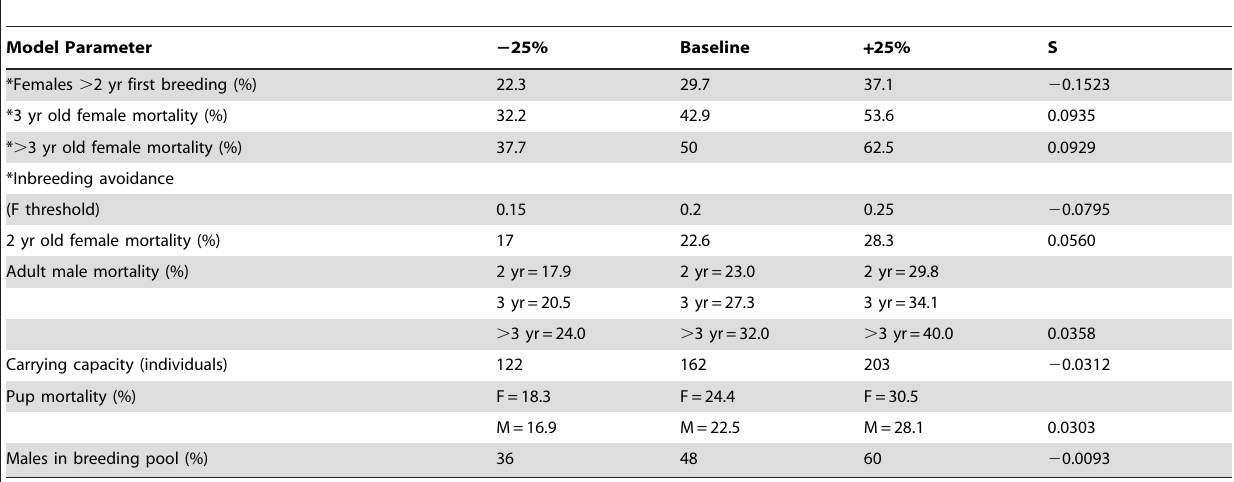
Table 2. Sensitivity analyses for selected model input variables with a 6 25% variation range in values for a simulated African wild dog